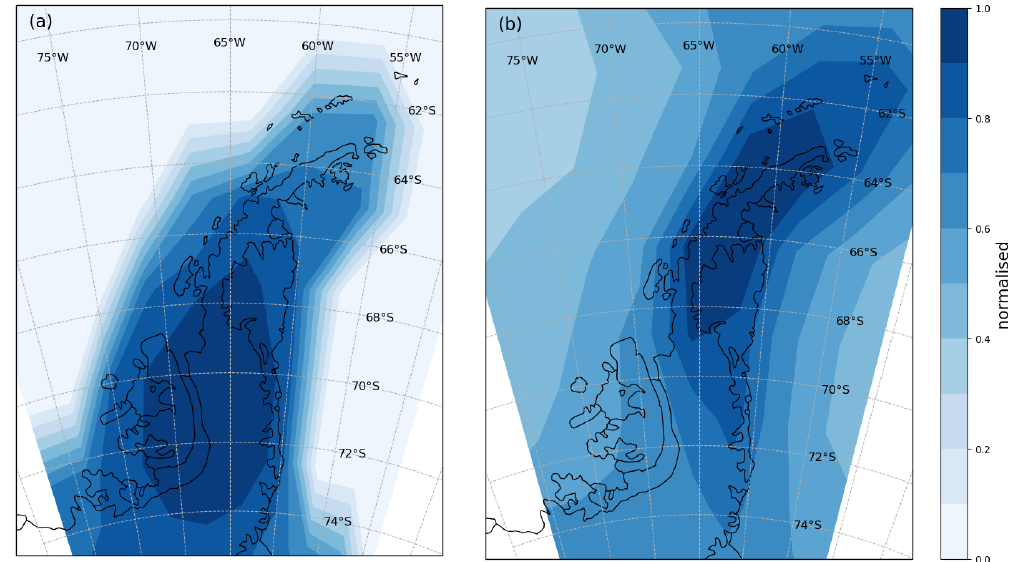
Figure 4. Map of the normalised number of instances that mountain-wave-induced cooling occurs over the Antarctic Peninsula in the (a) parameterised and (b) AIRS observations for May to October. Both the parameterised and AIRS results are based on the same information used to produce the probability distributions in Fig. 2. Note that the AIRS results also include some contribution from non-orographic wave sources. Note also that the maximum number is used to rescale and normalise the values from 0 to